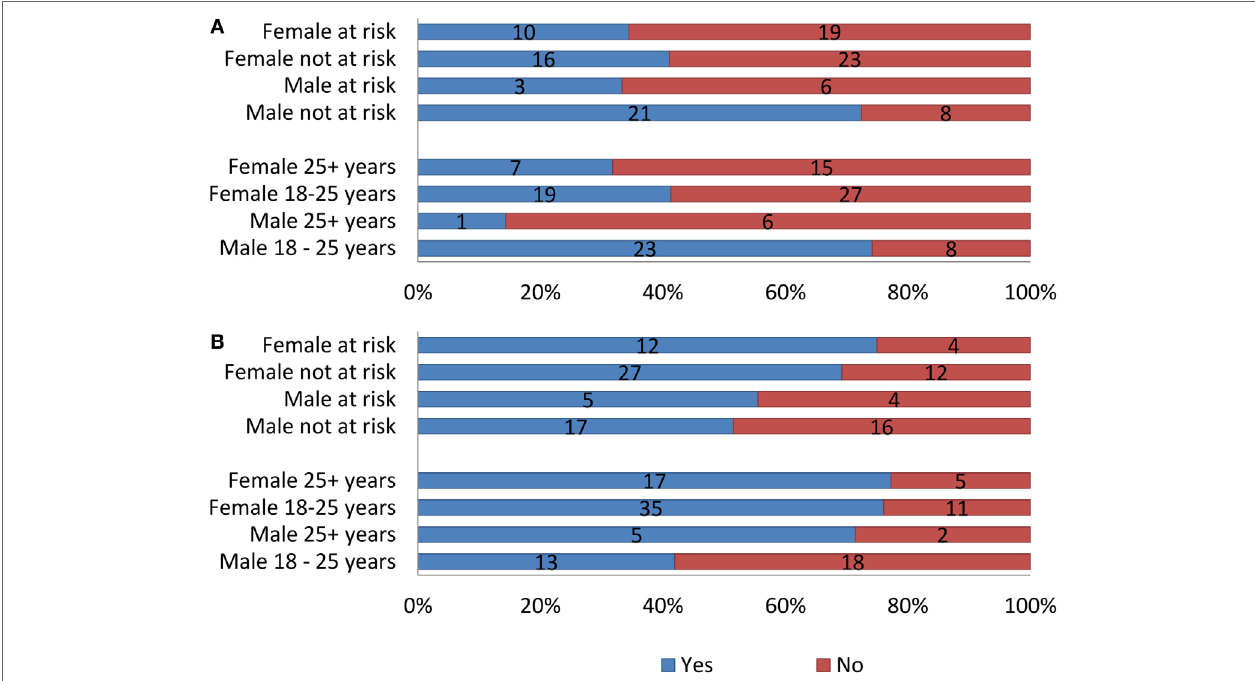
FigUre 5 | (a) Satisfaction with current weight. (B) Intention to lose weight in the stratified sample by age, gender, and at risk for developing eating